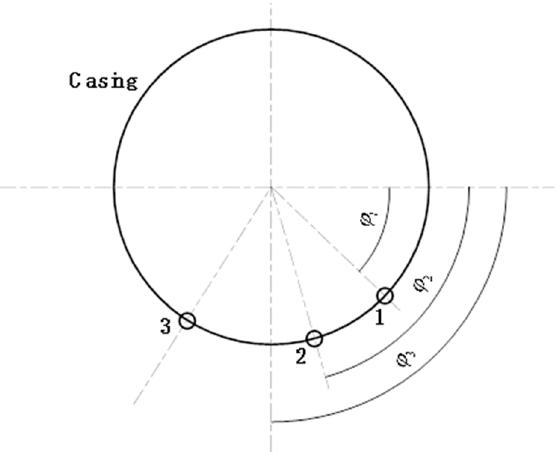
Figure 3. Diagram of rotor blade vibration measurement positions.